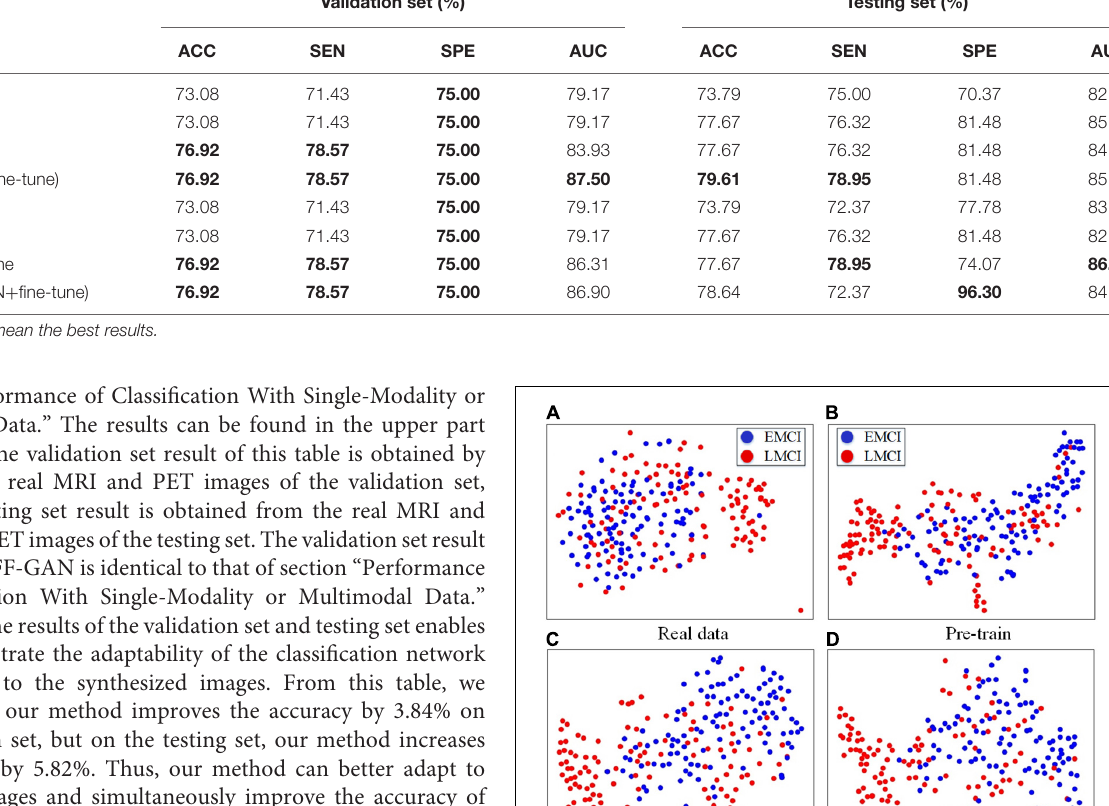
TABLE 4 | Classification performance obtained using different methods. Method